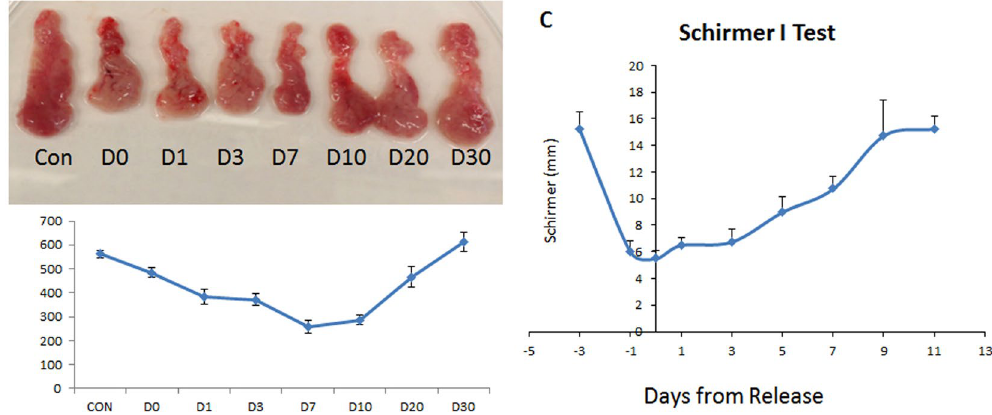
Figure 1. Gross morphology, weight and tear secretory function after ligation-induced injury. The size and weight of rabbit lacrimal glands decreased after reopening of the lacrimal gland main execretory duct from days 0–7 and then gradually recovered from days 10–30 ( A , B ). The Schirmer test showed a considerable decrease in tear secretion after ligation; it gradually increased to baseline within 10 days after release of the ligature ( C ). Con = control, D =